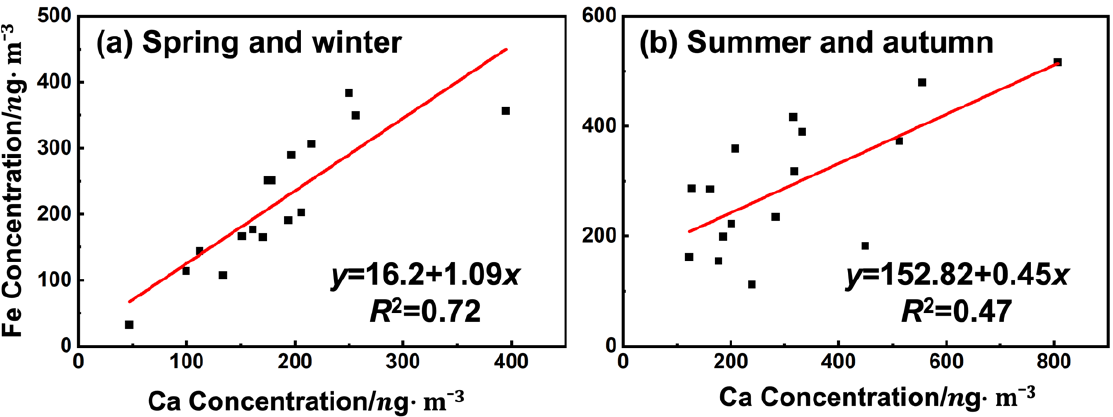
Figure 9. The correlation of Ca and Fe concentration (PM 3-10 ) during different seasons: ( a ) spring and winter; ( b ) summer and autumn;.